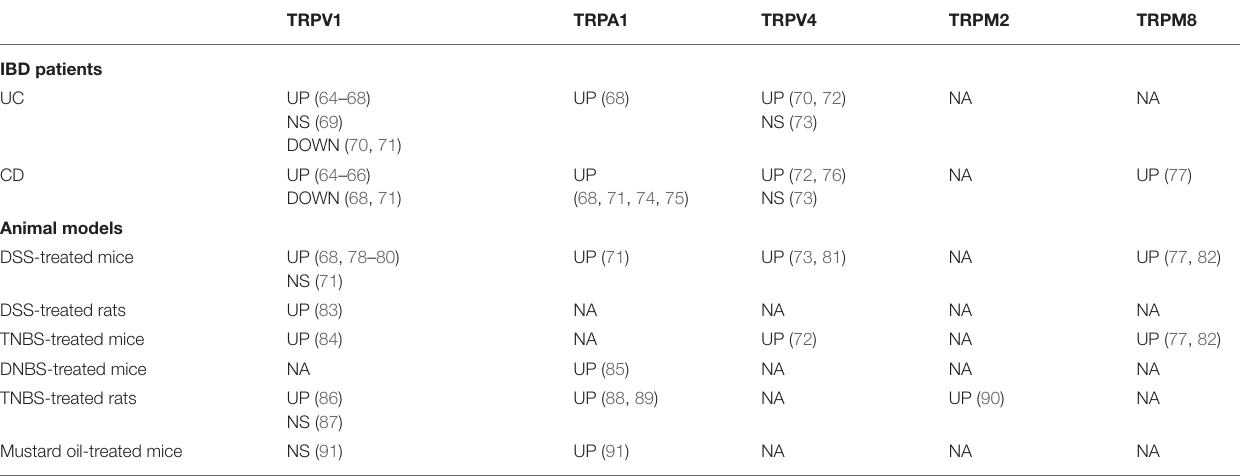
TABLE 1 | The expression of TRP channels in colonic tissue of IBD patients and colitis models. TRPV1